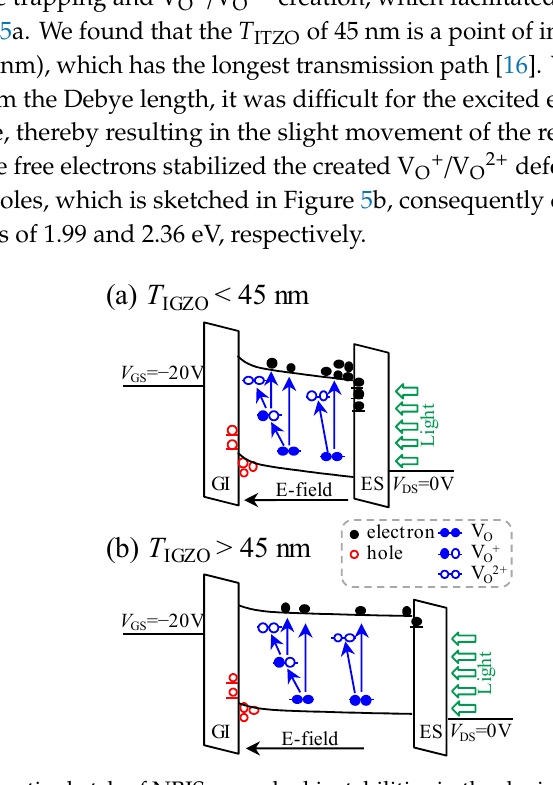
Figure 5. Diagrammatic sketch of NBIS-provoked instabilities in the devices with ( a ) T ITZO < 45 nm and ( b ) T ITZO > 45 nm.